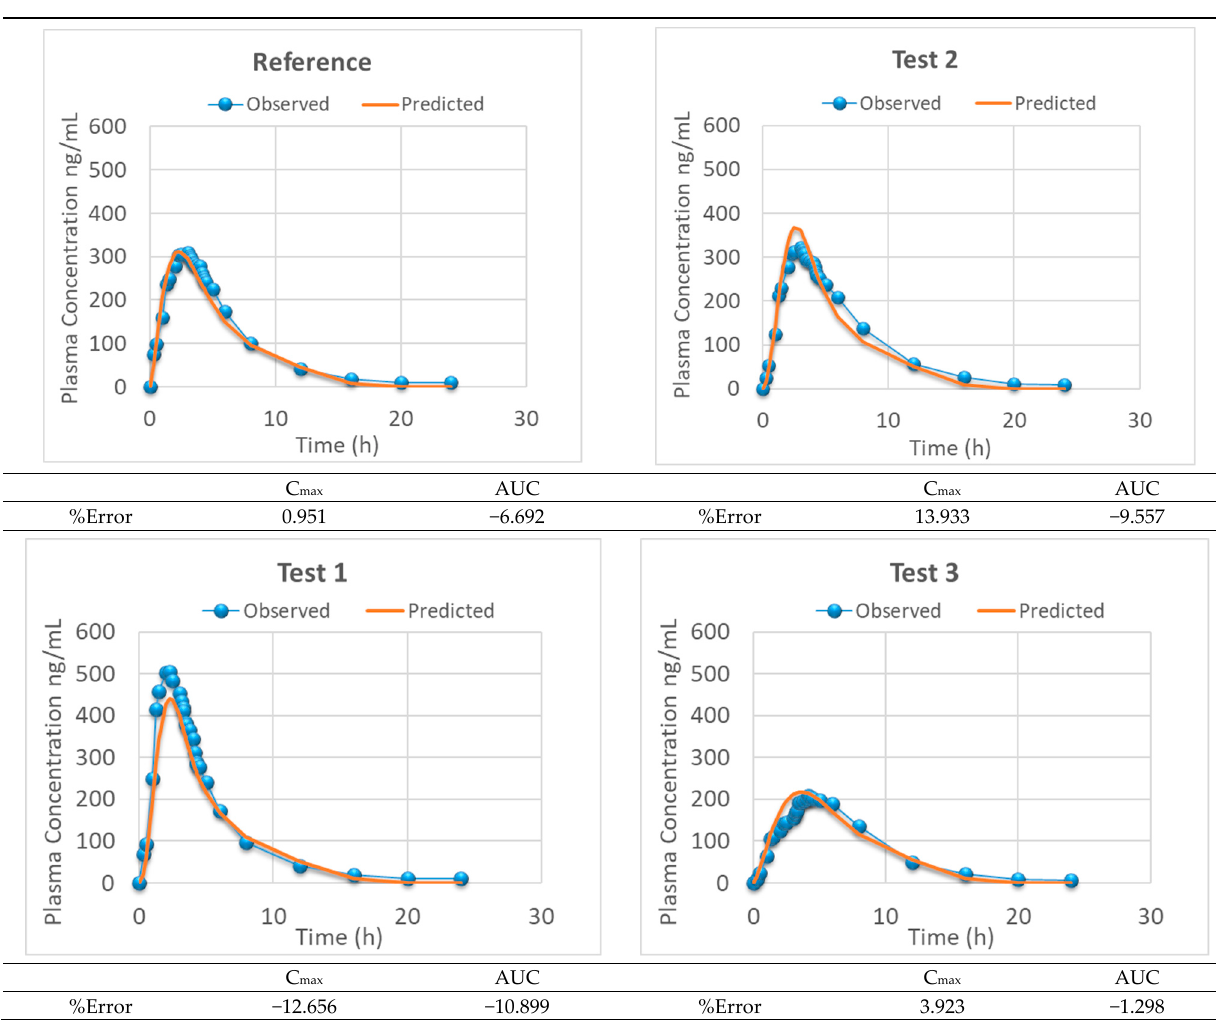
Figure 9. Experimental versus IVIVC ‐ predicted plasma levels representing the two ‐ step level ‐ A IVIVC of the four assayed products and the internal prediction errors .